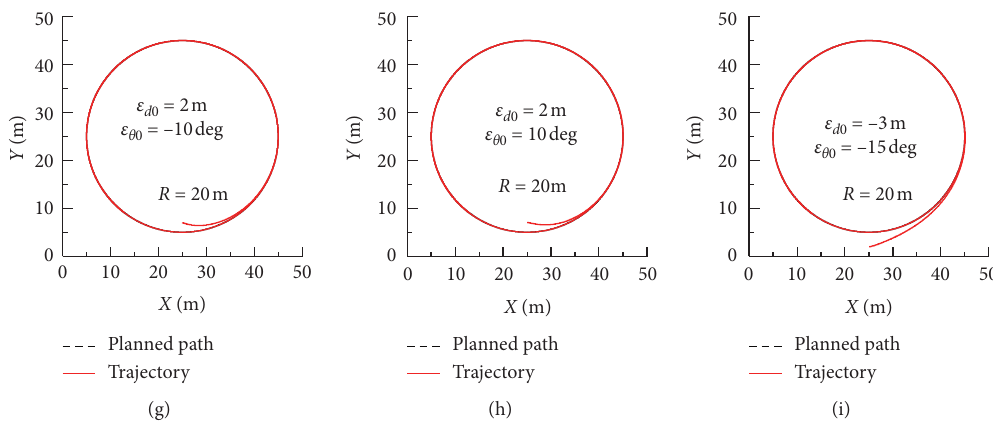
Figure 15: The circular path-following motions of the vehicle under different dynamic conditions.